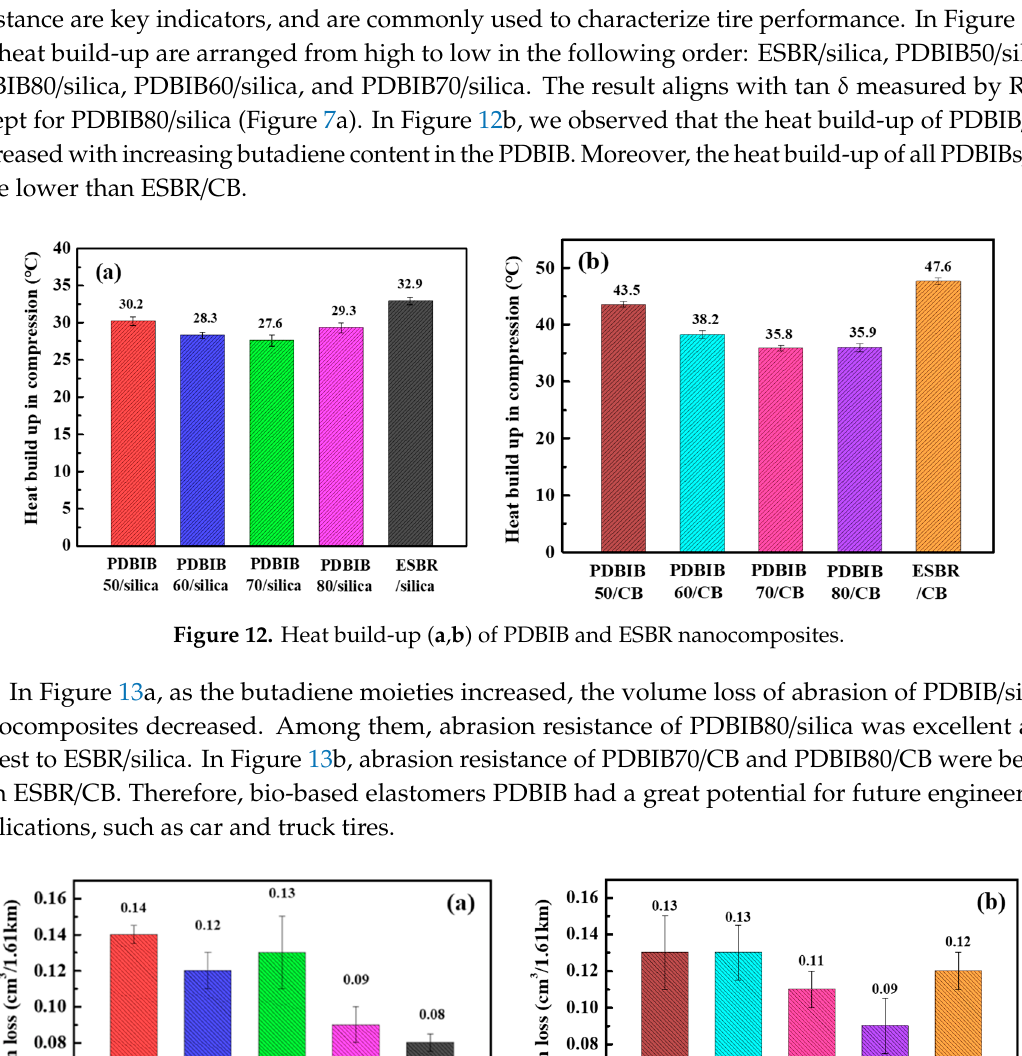
Table 9. Dynamic mechanical thermal analysis of PDBIB / silica nanocomposites.